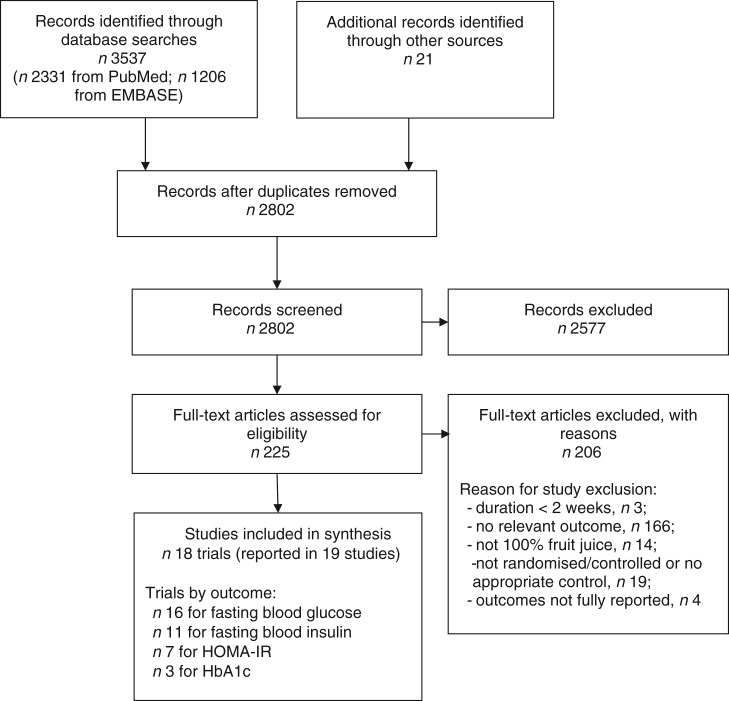
Flow diagram of study selection process. HOMA-IR, homeostatic model assessment of insulin resistance; HbA1c, glycosylated Hb.